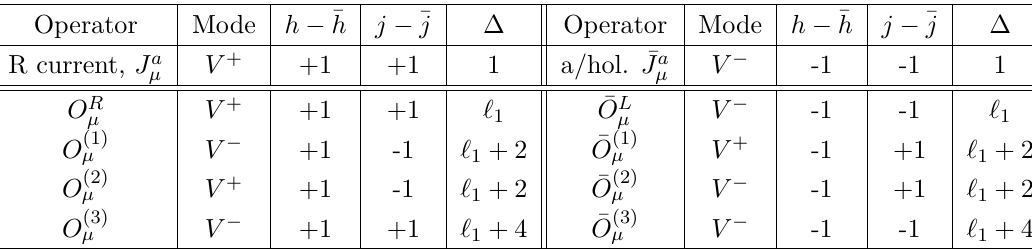
current. Here ∆ = h + ¯ h , ‘ = j + ¯ j R 1